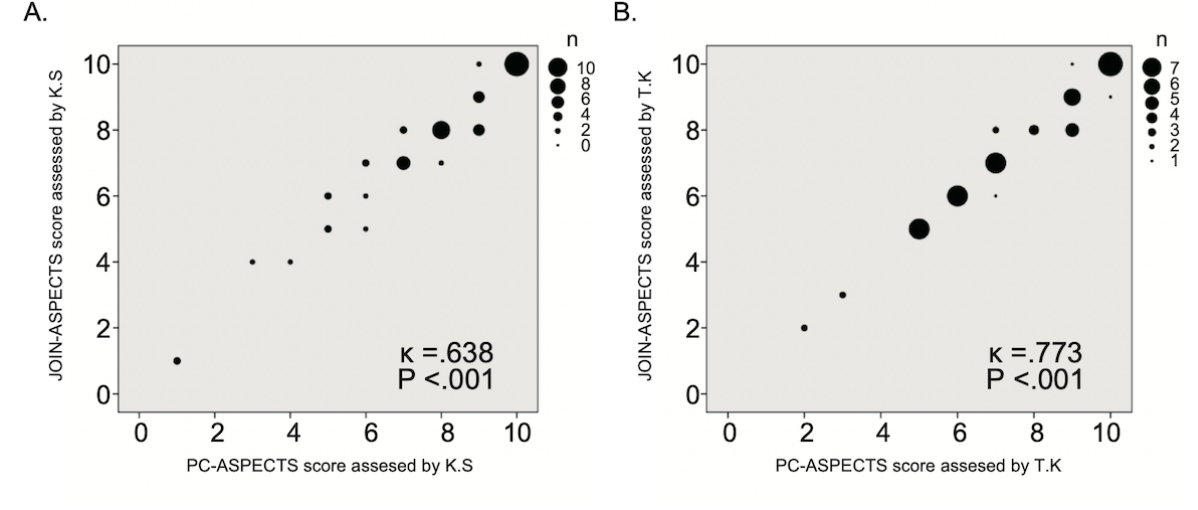
Figure 5. Scatter diagram of DWI-ASPECTS results of vascular neurologists KS (A) and TK (B) between JOIN-ASPECTS and PC-ASPECTS for 46 patients with major artery occlusion. DWI-ASPECTS: Diffusion-Weighted Imaging–Alberta Stroke Program Early Computed Tomography